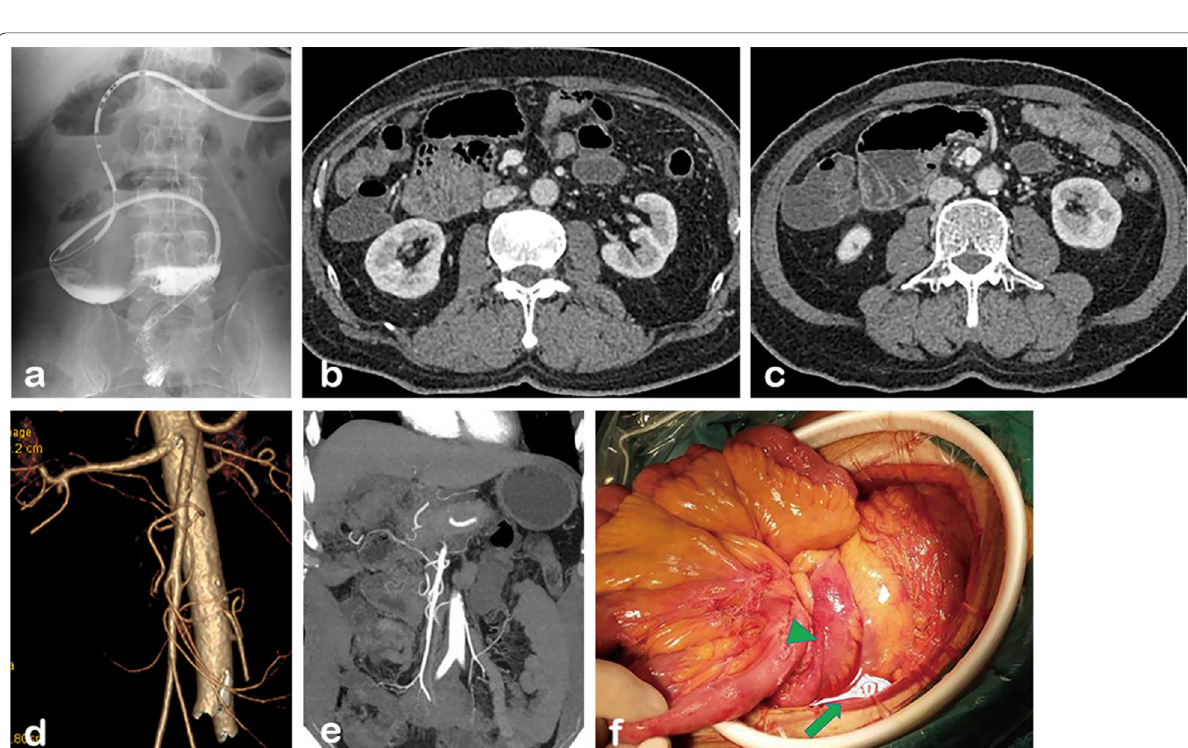
Fig. 6 A 64-year-old man developed volvulus after radical resection of rectal cancer (D N J R C R , type 1a). a Endoscopic catheterization: After passing through the duodenum, which was located to the right of the midline, the catheter was unable to pass smoothly into the misplaced obstructed proximal jejunum. b , c CT showed that the duodenum and jejunum were located in the right upper abdomen. d , e CTA shows SMA and its branches. 6f: Ladd’s bands were found during surgery (arrow). The terminal ileum was visualized